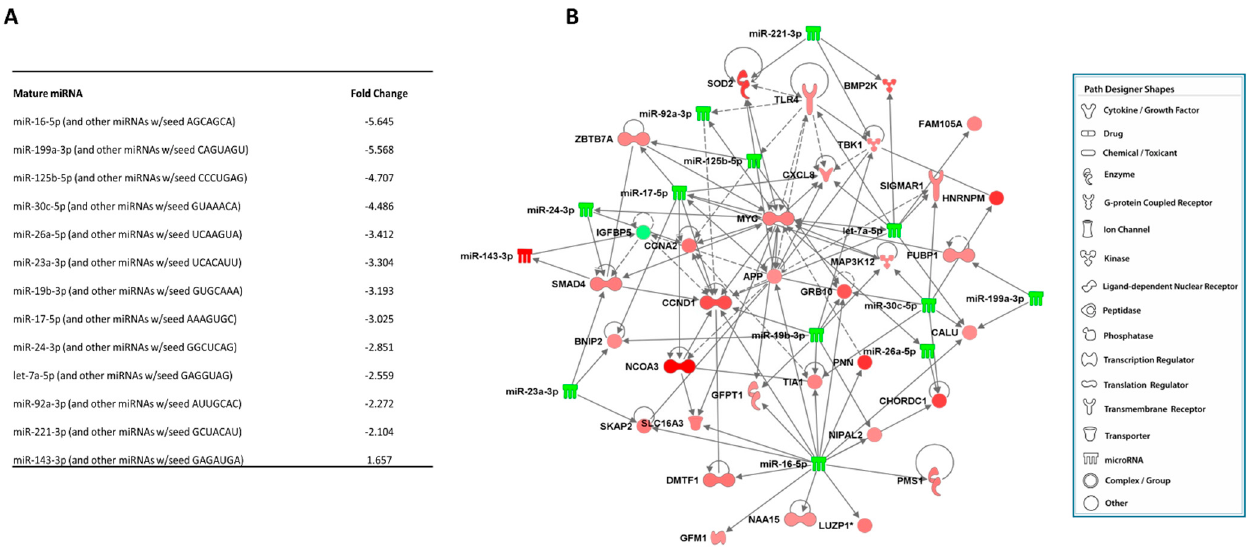
Figure 4. ( A ) List of 13 differentially expressed miRNAs in CNIT samples. ( B ) Integrated network of 13 miRNAs and their downstream up- (red) and down- (green) regulated genes.